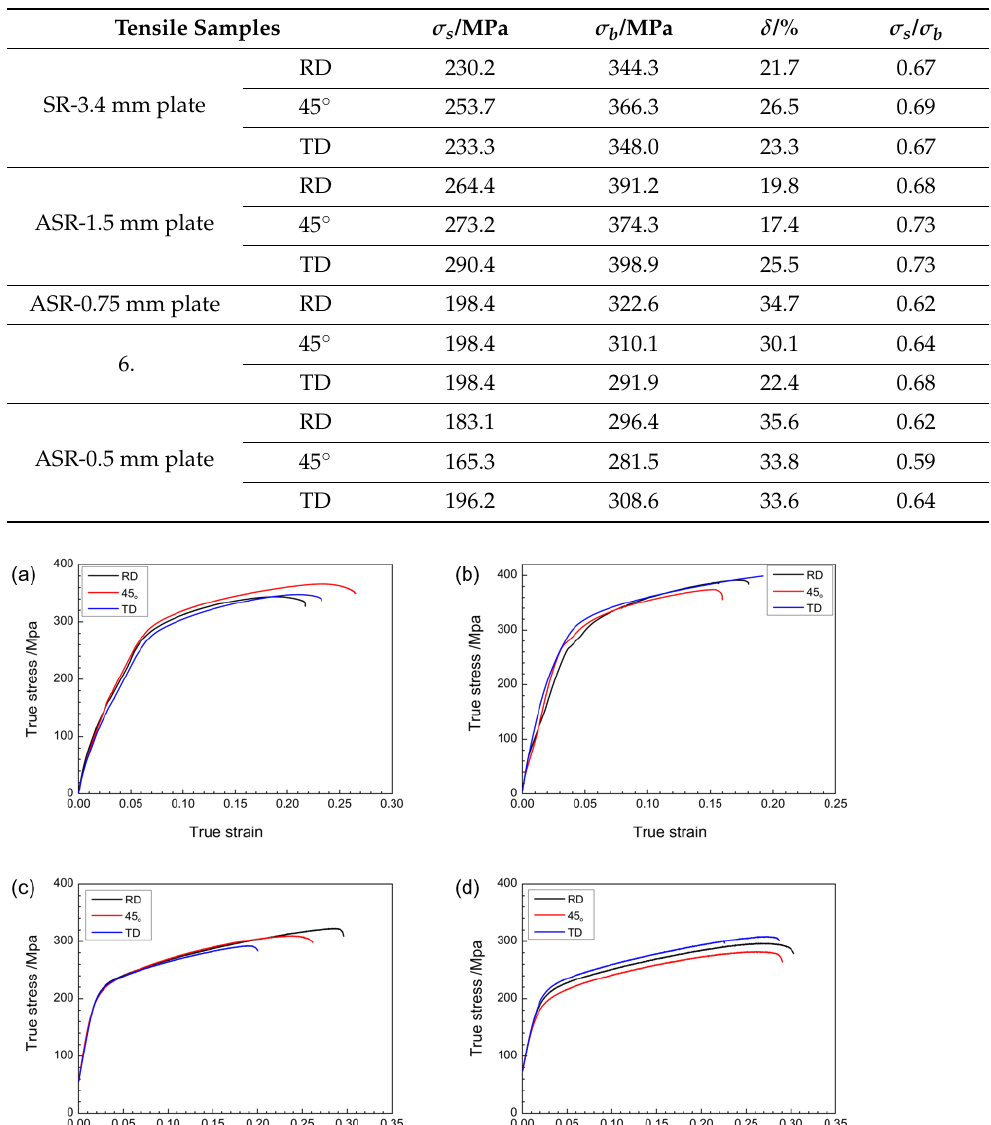
Figure 8. EBSD-measured IPF maps, (0001) PFs, and misorientation-angle distribution of ASR: ( a ) ASR-1.5 mm, ( b ) ASR-0.75 mm, ( c ) ASR-0.5 mm.